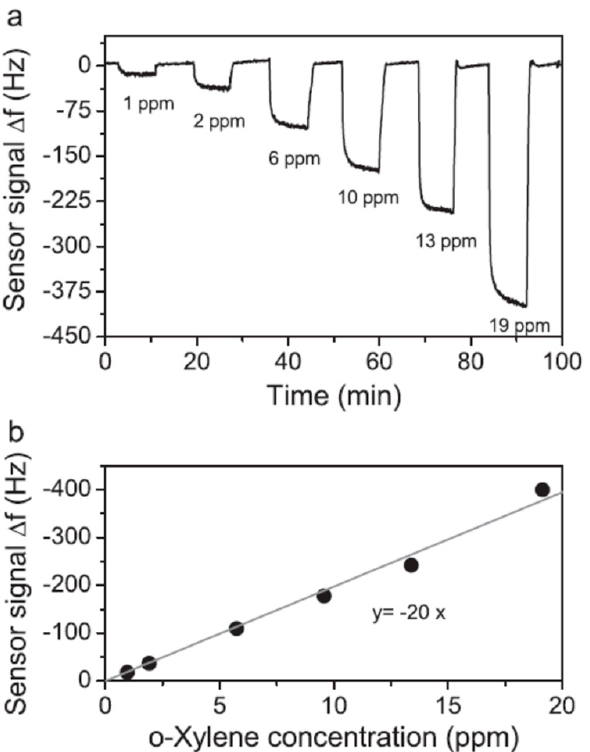
Figure 16. Transient signal of a QCM sensor with the film of octasubstituted CuPc derivative (Com- pound 15 c, Table 1) during exposure to samples containing o-xylene in concentration between 1 and 20 ppm ( a ) and resulting calibration curve ( b ). Reprinted from [109] with permission from Elsevier. It was shown that the sensor response increased for all materials in the order dichloro- methane < chloroform < toluene < chlorobenzene < tetrachloroethylene < p-xylene < o-xylene. The maximal response was observed for octasubstituted phthalocyanine (Com- pound 15 c, Table 1) with the LOD of dichloromethane of 5 ppm and the LOD of o-xylene of 0.05